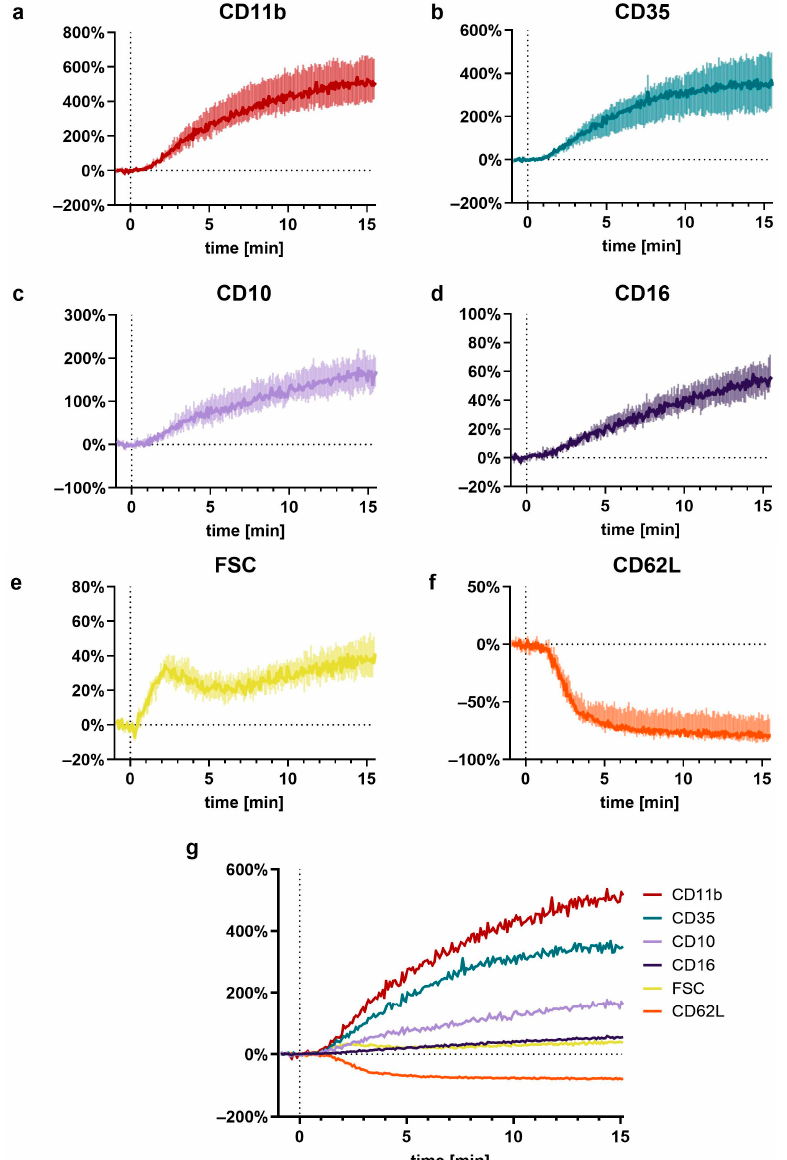
Figure 7. Near-realtime description of the C5a-induced (10 nM) effects on neutrophils for ( a ) CD11b, ( b ) CD35, ( c ) CD10, ( d ) CD16, ( e ) FSC, ( f ) CD62L, and ( g ) a summary of all these factors. Reported are the changes normalized to neutrophils prior to stimulation (= 0%) as the median with shaded areas indicating the interquartile range, n = 7–8.